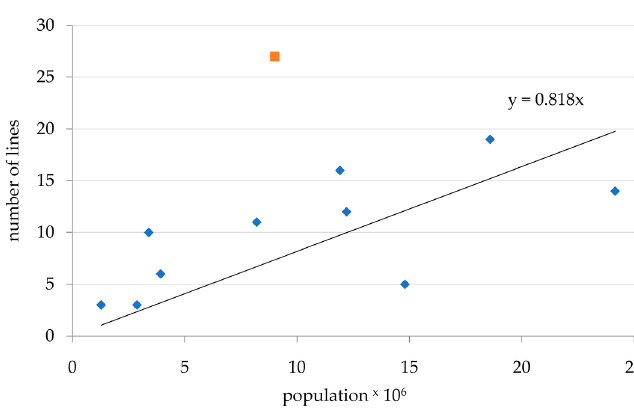
Figure 2. Dependency between the population size and the number of metro lines.